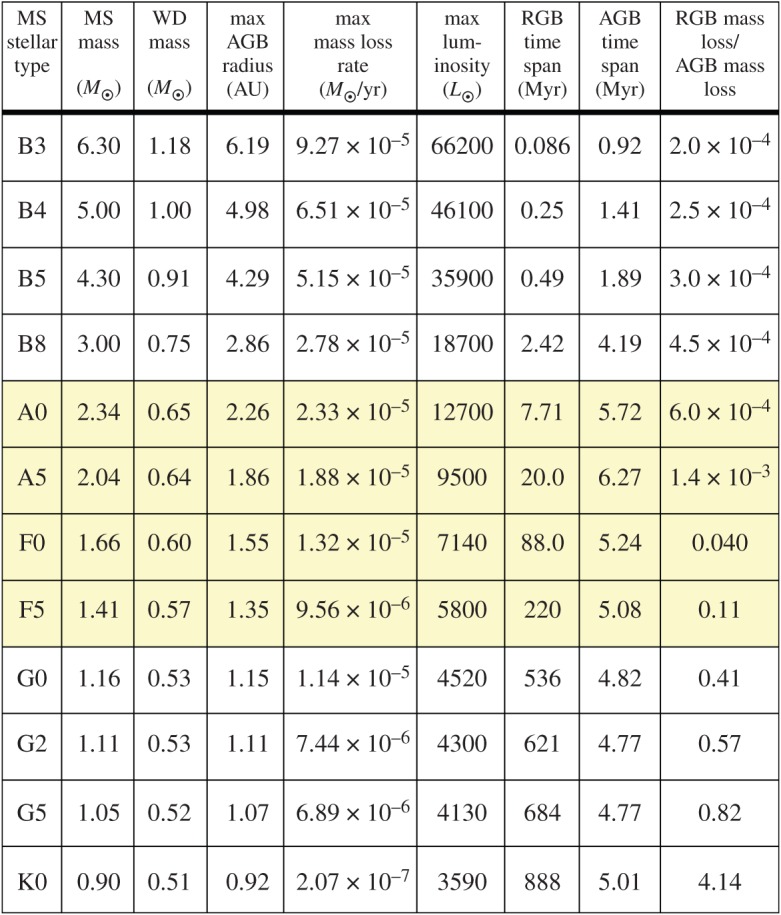
Useful values for 12 different stellar evolution tracks. I mapped the first column to the second by using appendix B of [26], and then created the remaining columns by using the sse code [27] by assuming its default values (which includes Solar metallicity). The four highlighted rows roughly represent the range of the most common progenitor stars for the present-day WD population in the Milky Way.